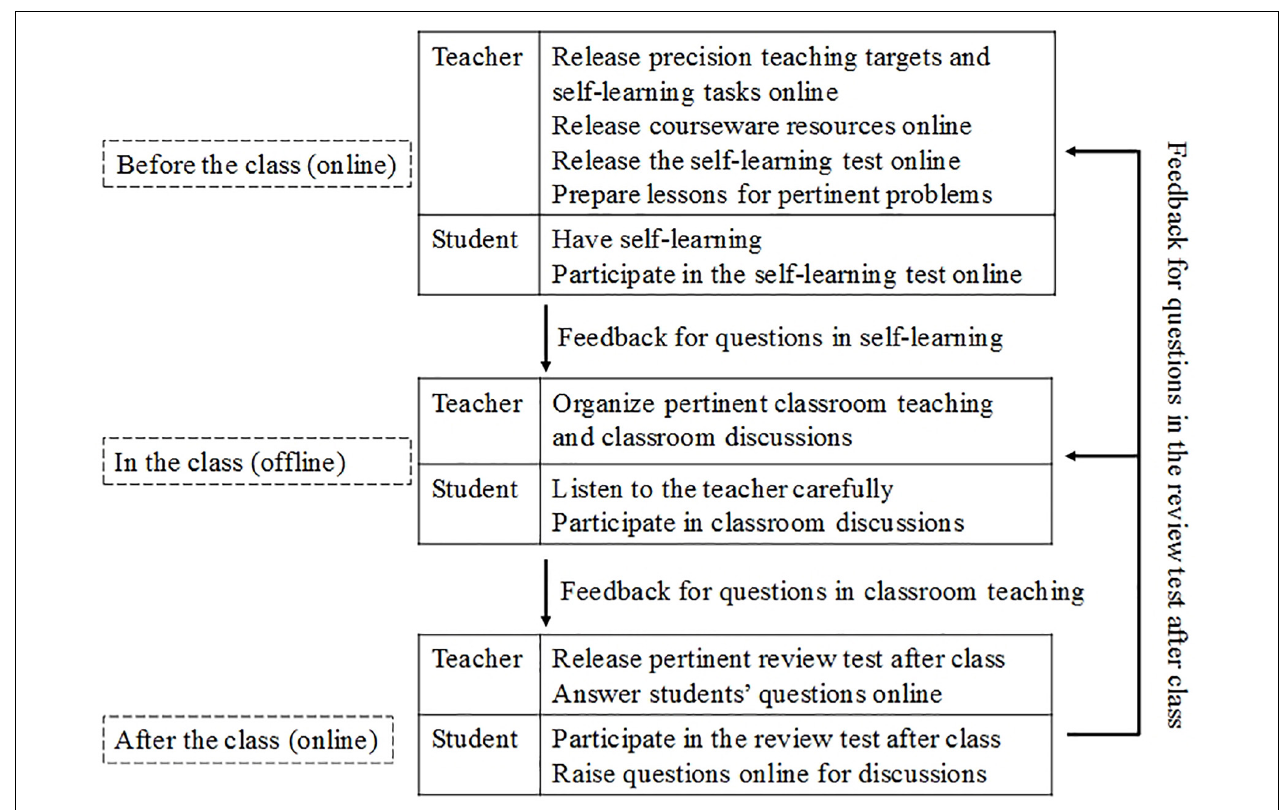
FIGURE 3 | Blended learning process featuring precision teaching.